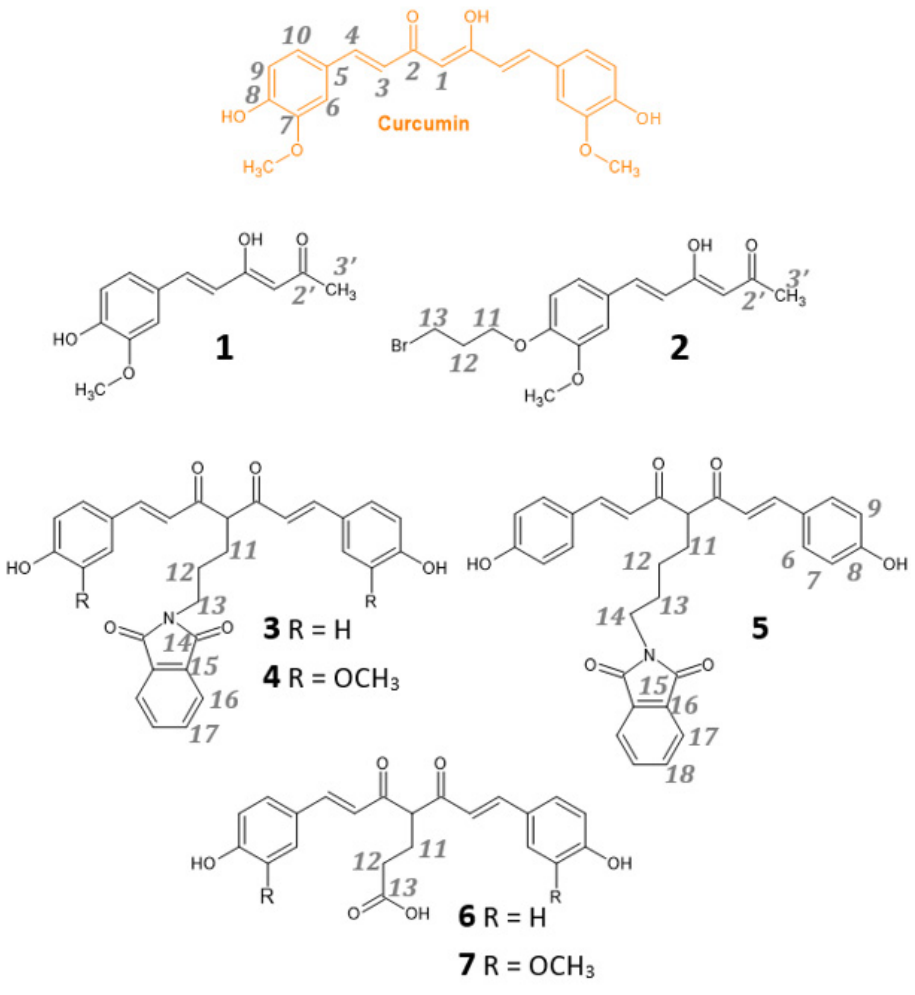
Figure 1. Chemical structures of curcuminoids and atom numbering for NMR signals’ assignment.